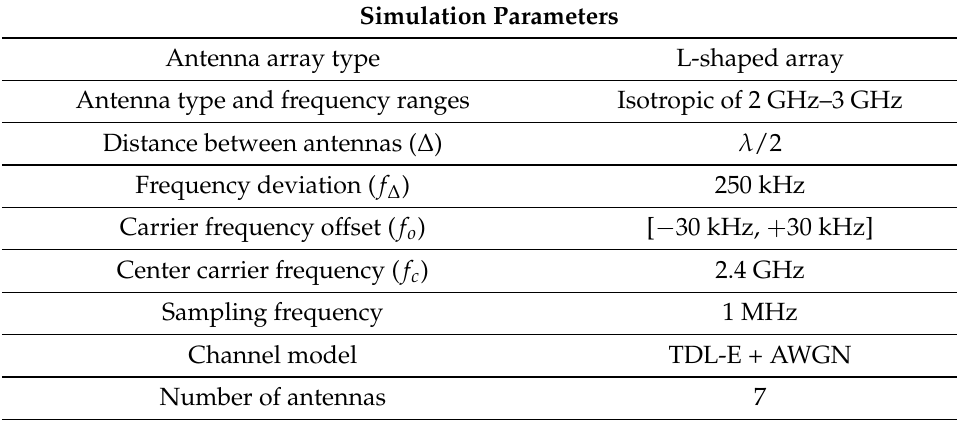
Figure 7. Overview of the experiment. Table 1. Simulation parameters in